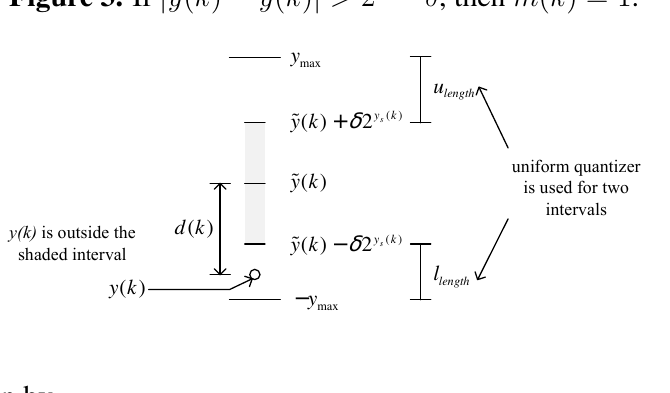
Figure 3. If j y ( k ) ¡ ˜ y ( k ) j > 2 y s ( k ) δ , then m ( k ) = 1